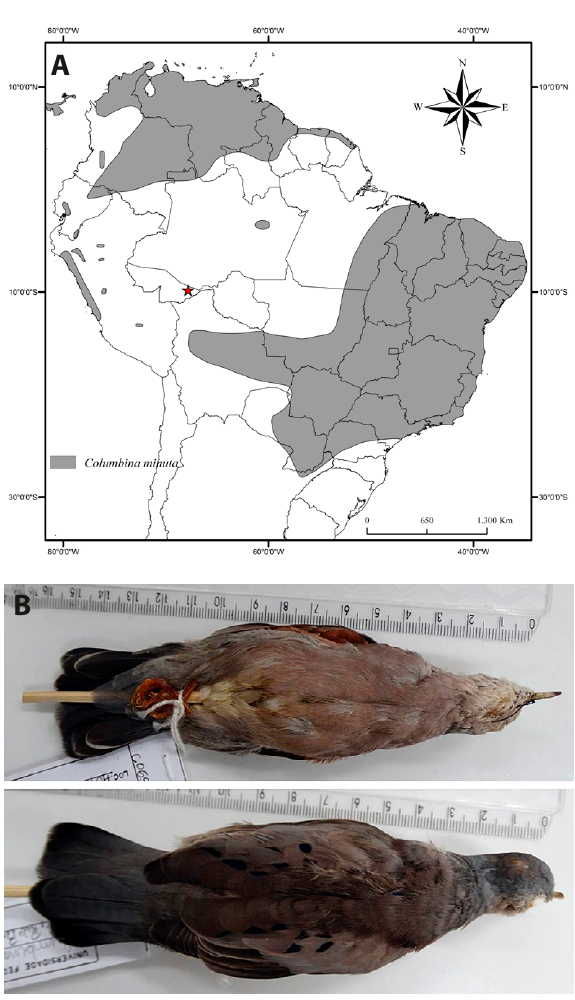
Figure 3. (A) Range (grey) of Plain-breasted Ground-Dove ( Colum- bina minuta ) in South America and (B) documented record of the species presented in this study (red star, voucher number AC 755) and Guilherme (2016). Photos by Edson